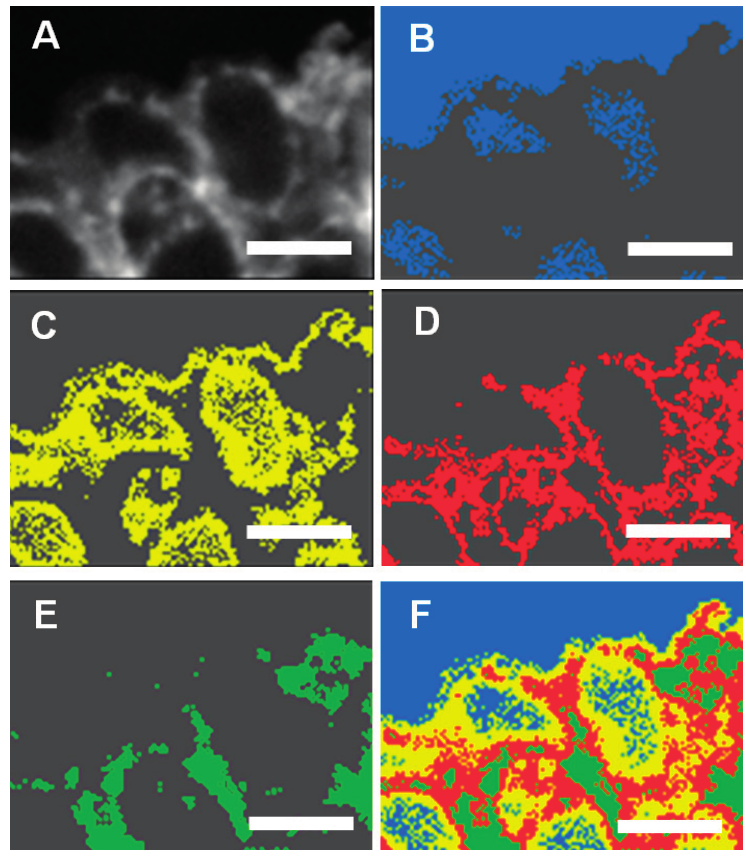
Figure 3. High-resolution (50 nm) spatial distribution of total Ca in E. huxleyi determined by STXM-NEXAFS spectromicroscopy. ( A ) Contrast tomography image; ( B ) Cluster 1 of background with blue color; ( C ) Cluster 2 of Ca form with yellow color; ( D ) Cluster 3 of Ca form with red color; ( E ) Cluster 4 of Ca form with green color; ( F ) Merged images of ( B – E ), Scale bars: 1 μ